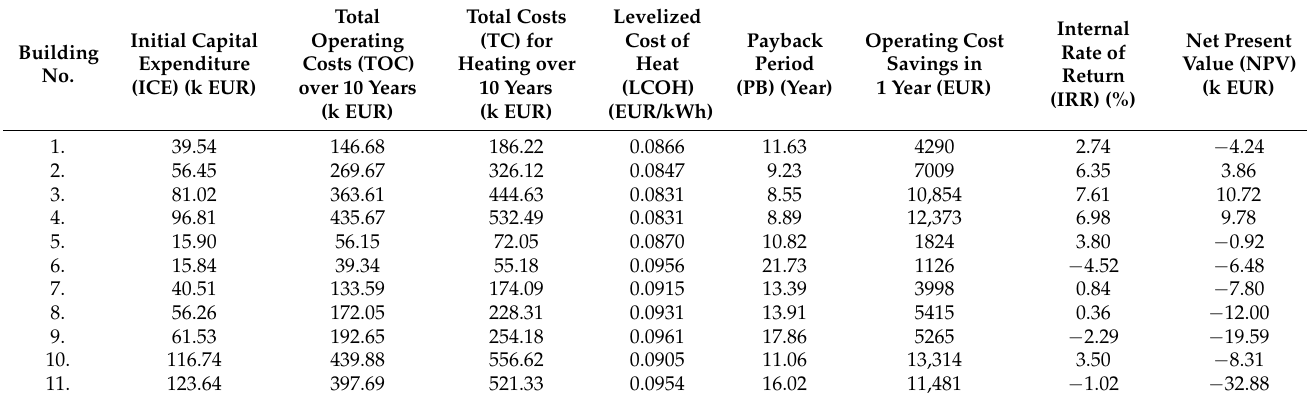
Table 3. Results of economic and financial analysis for analyzed heat